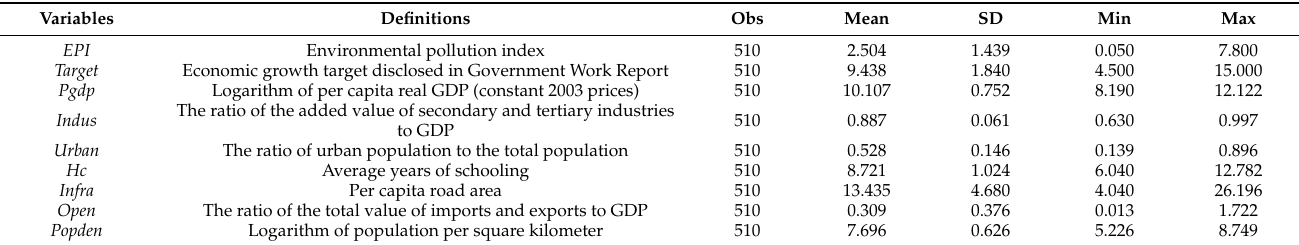
Table 1. Definitions and descriptions of